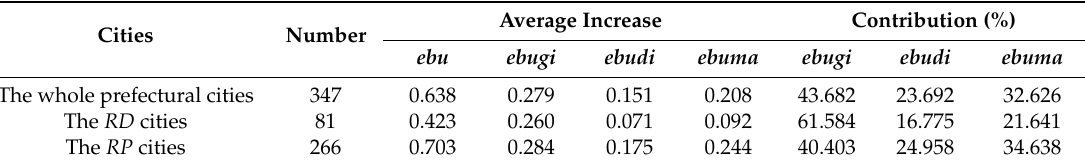
Table 3. Change in environmental benefits of urban land use, 2000–2010.